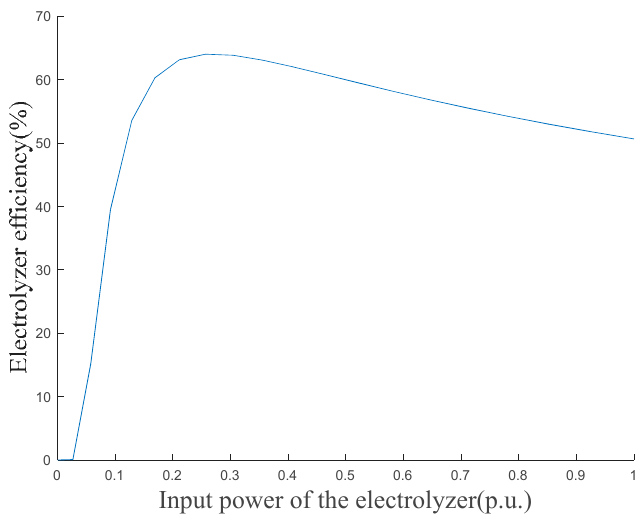
Figure 2. Electrolyzer efficiency characteristic.